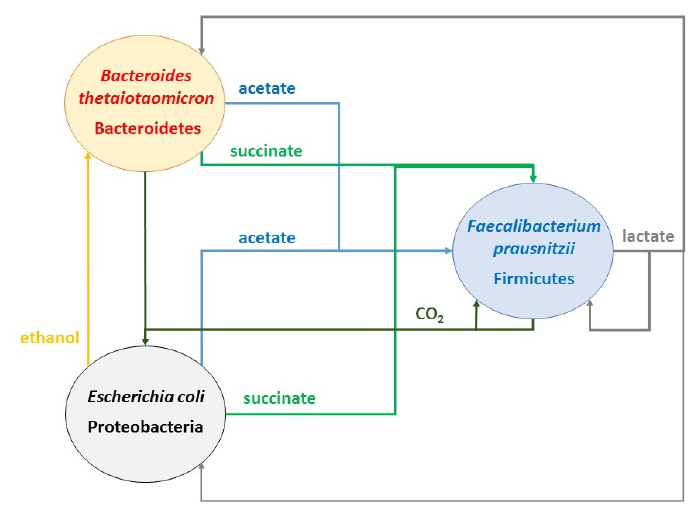
Figure 4. Byproduct cross-feeding patterns identified from the species uptake and secretion fluxes in Figure 3B. Formate cross feeding has been omitted due to its small magnitude and